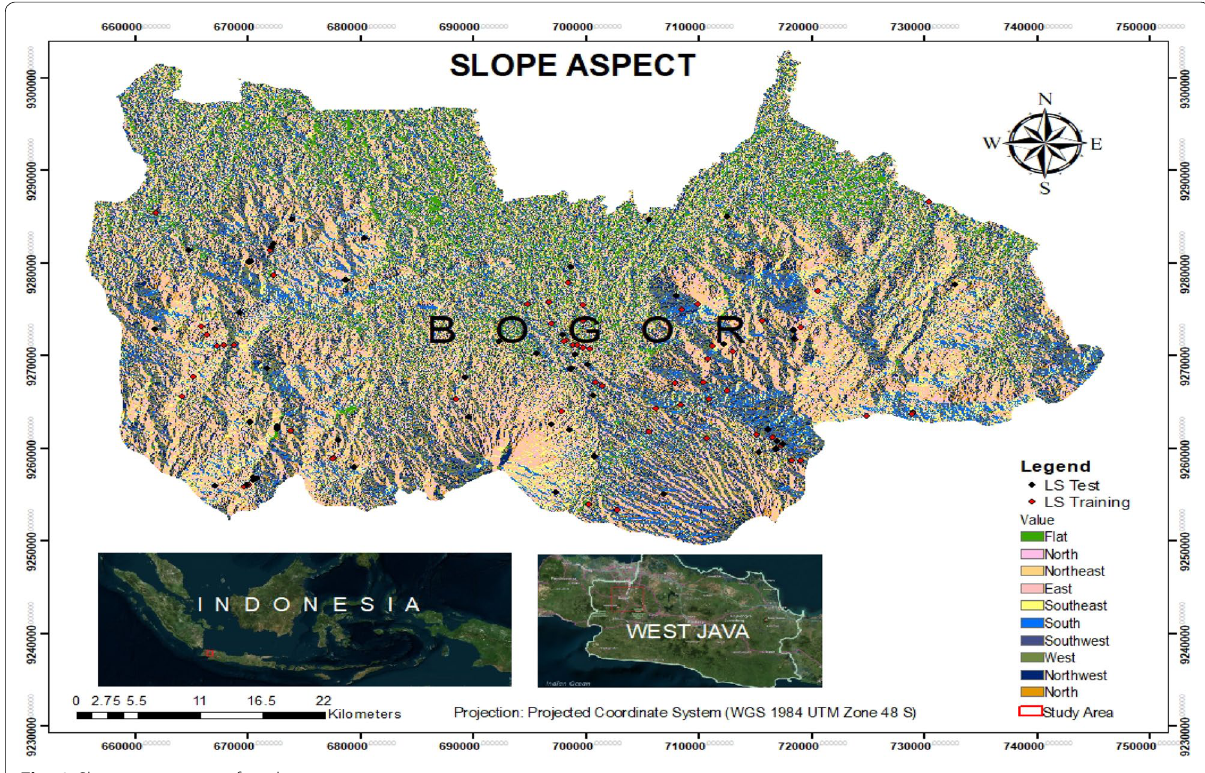
Fig. 6 Slope aspect map of study